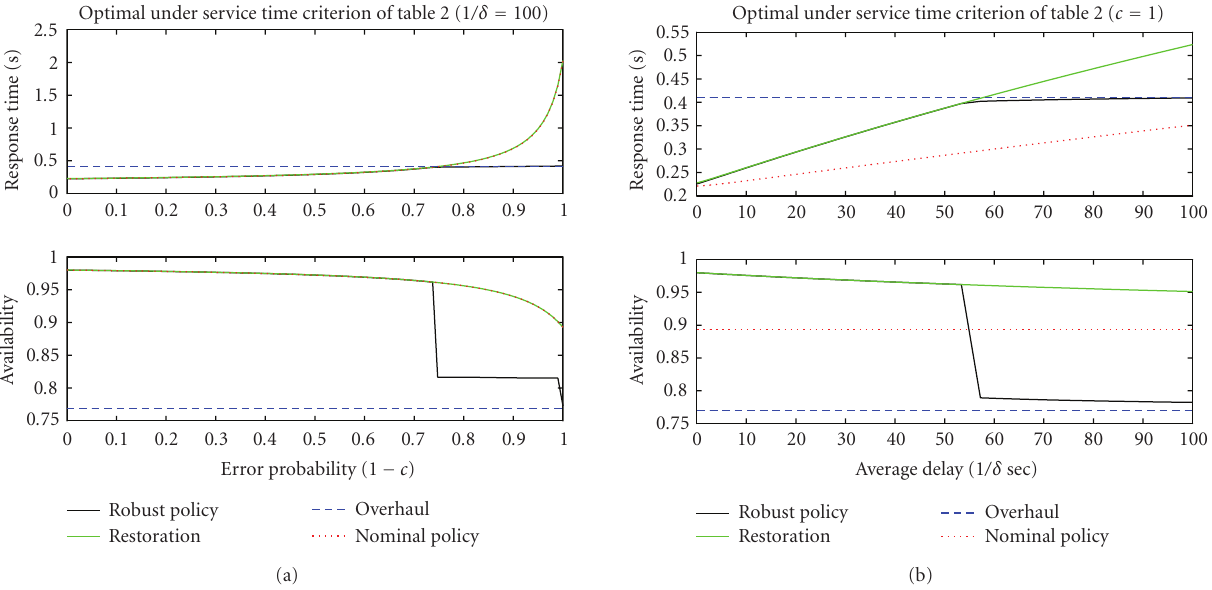
Figure 10: Response time (upper panel) and availability (lower panel) resulting from robust control policy (solid black) and nominal control policy (dotted red) versus (a) decision error (1 − c ) and (b) control delay (1 /δ ).